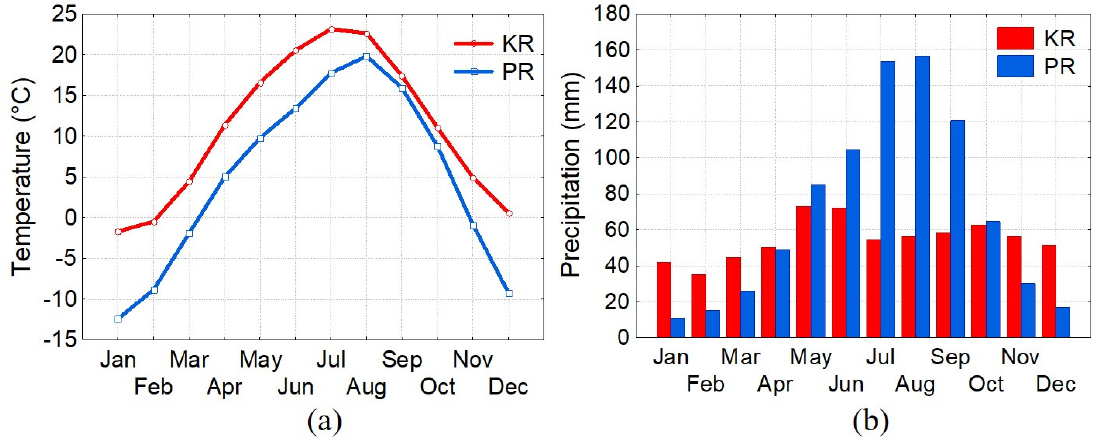
Figure 2. Average monthly temperatures ( a ) and the sum of the precipitation ( b ) at the experimental locations in 1970–2019.